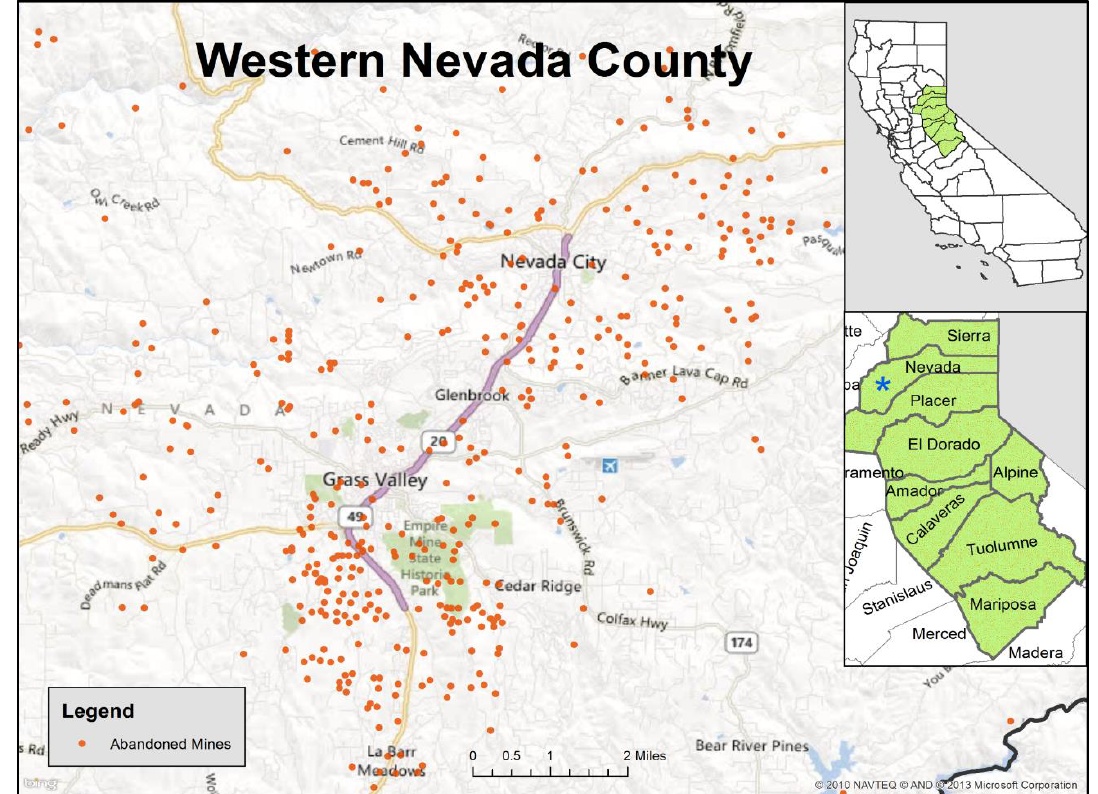
Figure 1. Map of abandoned mine sites in western Nevada County, California. Insets show Gold Country counties. (Source: US Geological Survey).